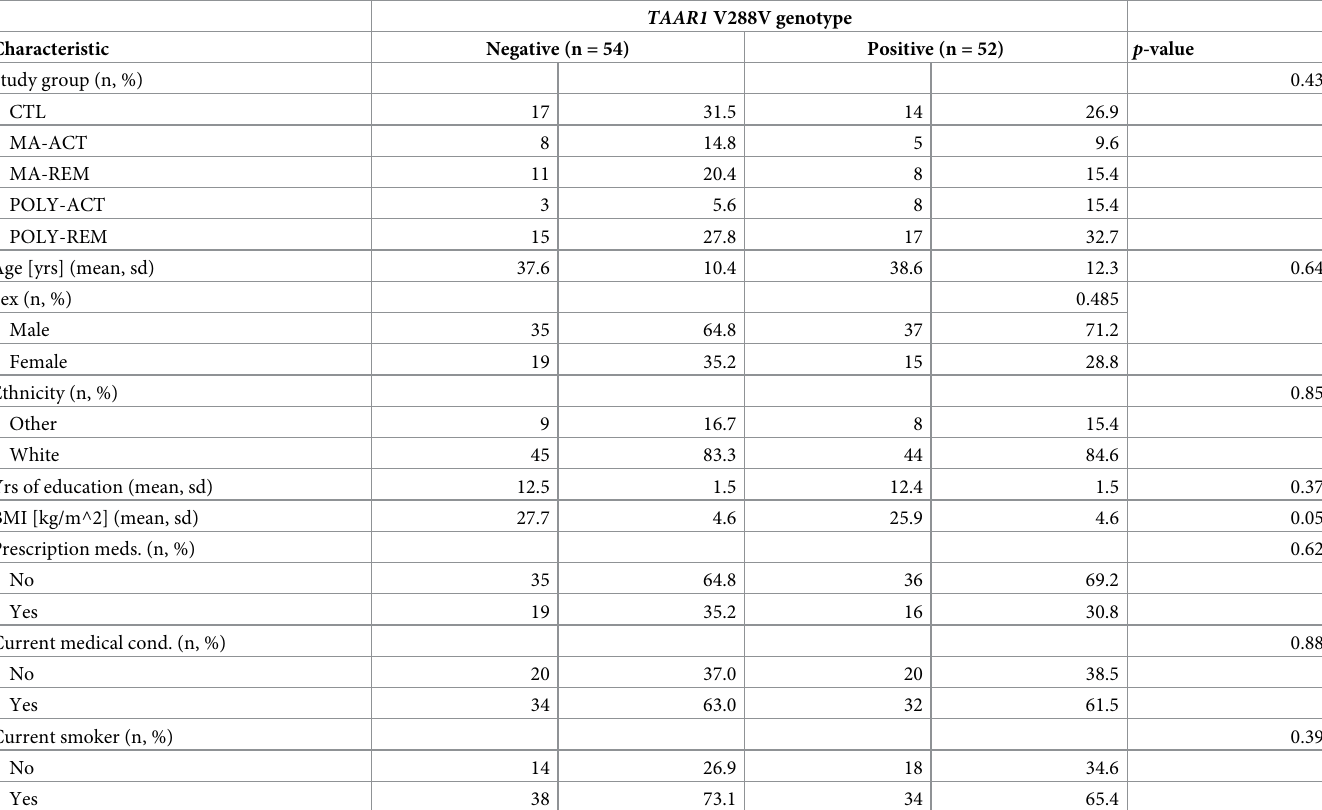
Table 1. Demographic and clinical characteristics of study participants with and without a history of dependence on methamphetamine and other